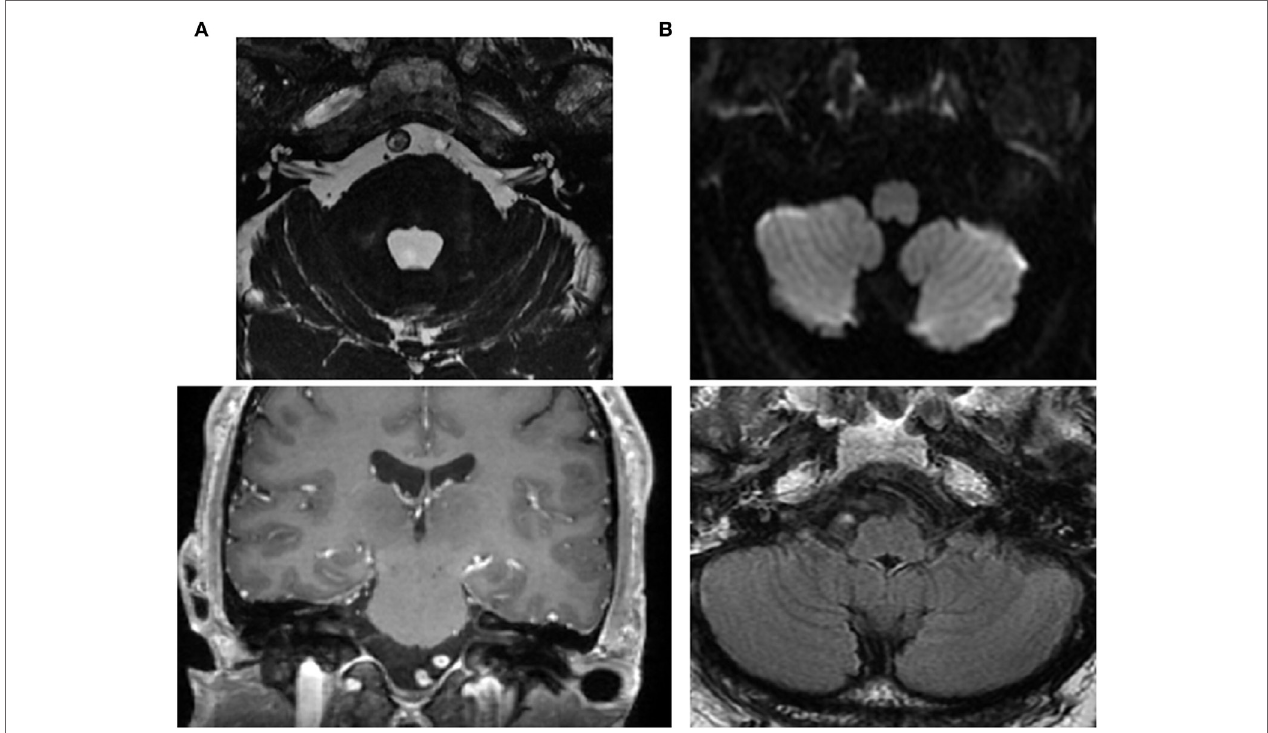
FIgURe 4 | Brain MRI. (a) Normal internal auditory canals as visualized via axial FIESTA (upper) and coronal T1 with contrast (lower). (B) Normal inferior and medial vestibular nuclei at the level of the medulla (axial diffusion—upper) and FLAIR (lower).